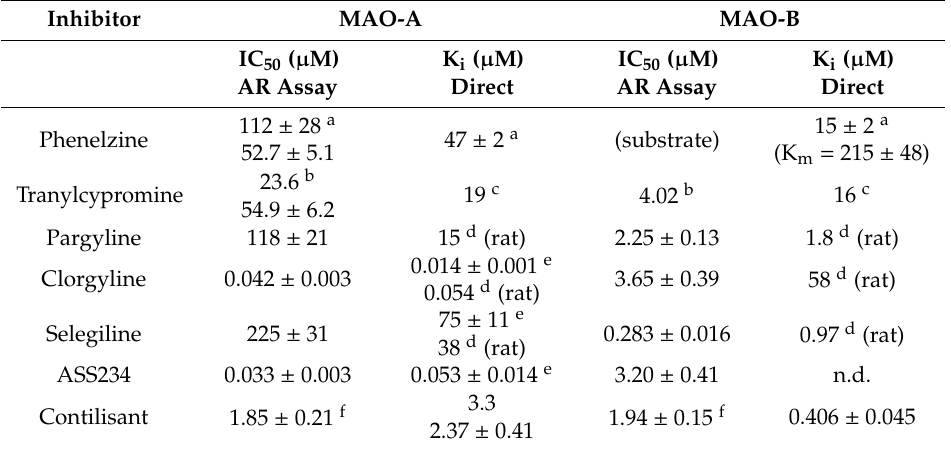
Table 1. Initial reversible inhibition by mechanism-based inhibitors of MAO. Inhibitor MAO-A